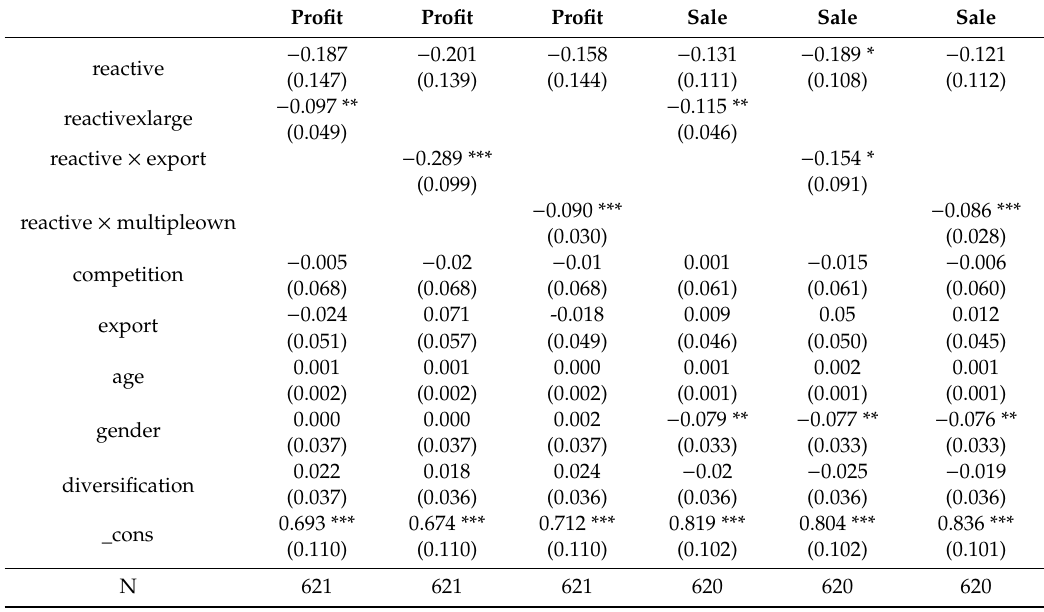
Table 6. Regression results of interactive reactive technological